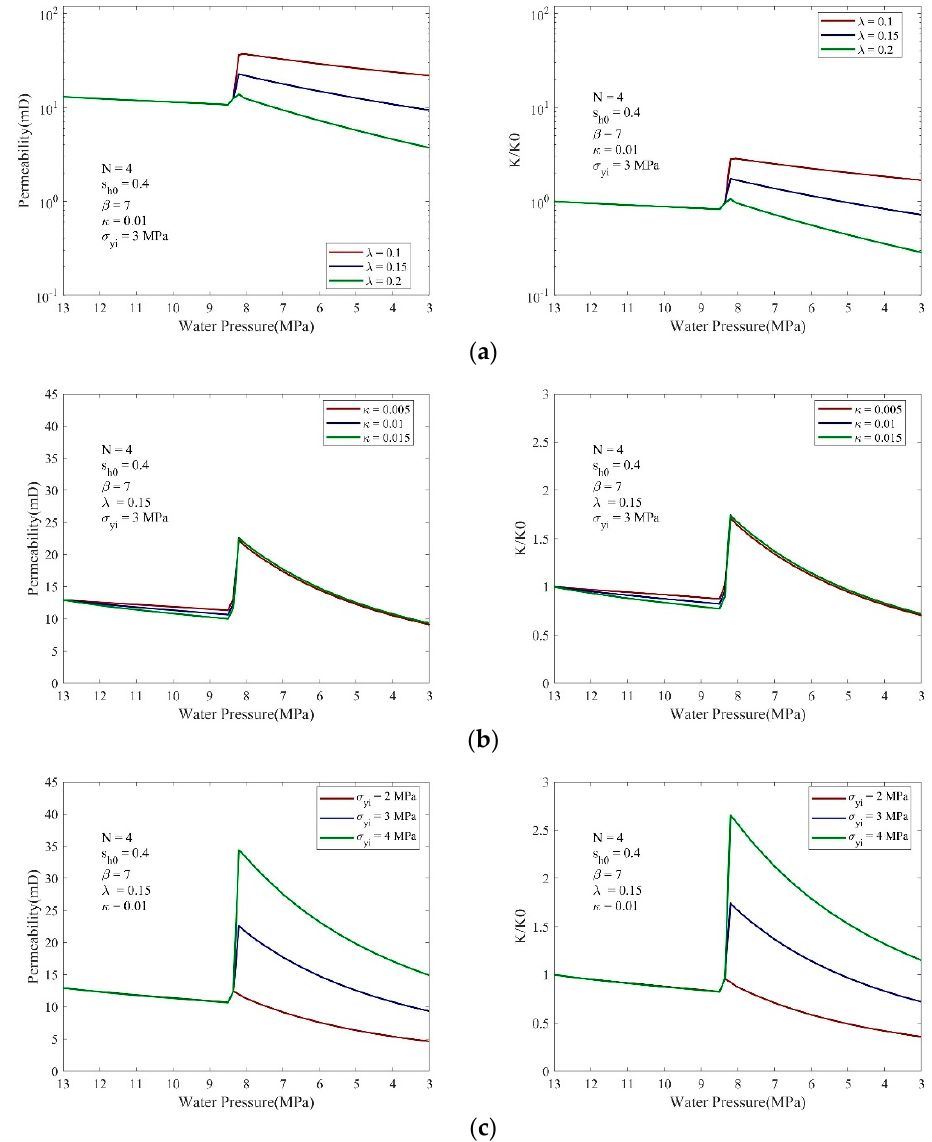
Figure 9. The impact of different parameters including ( a ) parameter λ , ( b ) parameter κ and ( c ) precondition pressure σ y on permeability (Left figures—permeability, Right figures—permeability ratio).